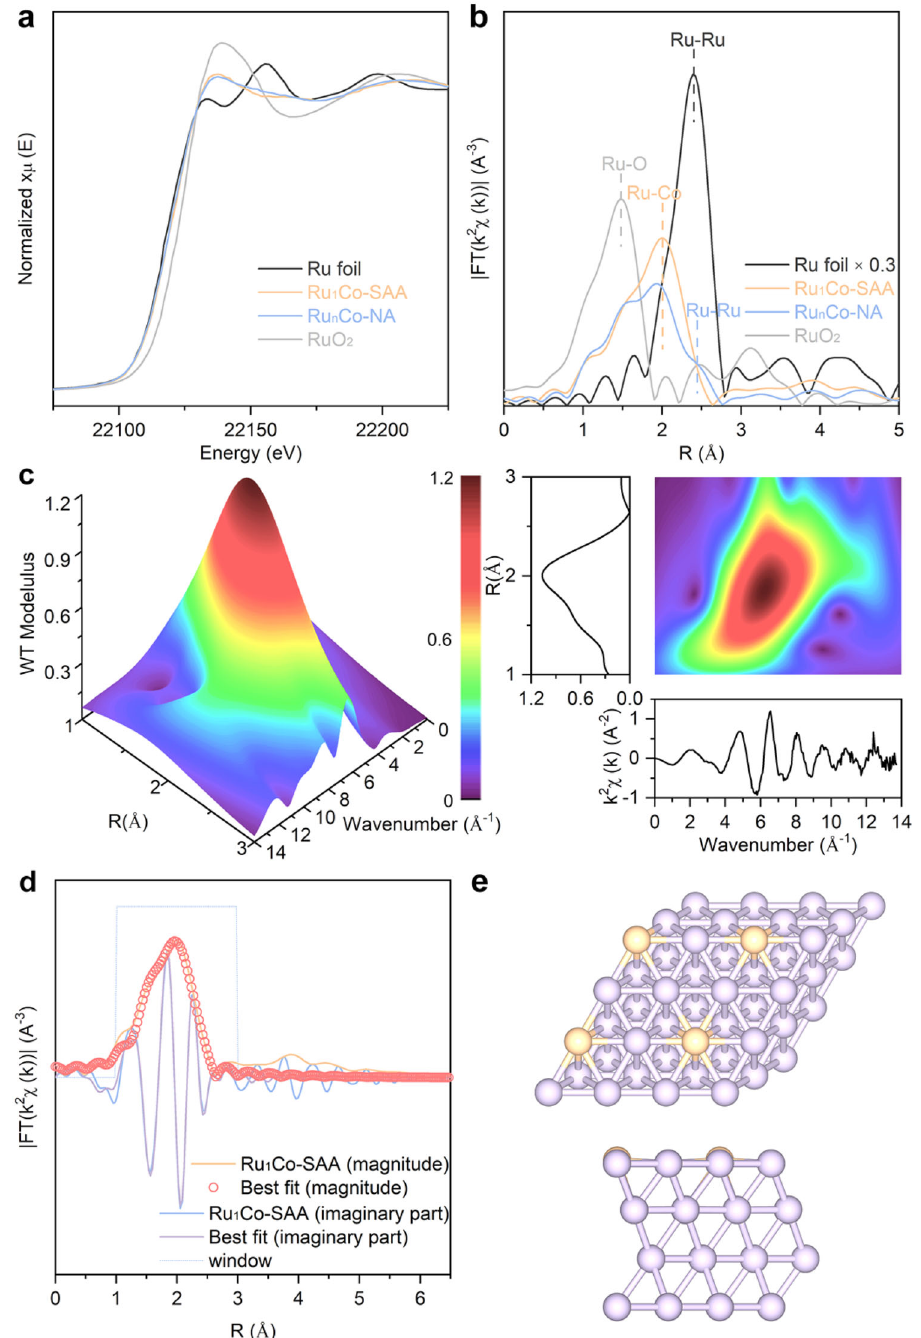
Fig. 3| Structuralcharacterization oftheRu 1 Co-SAAcatalyst.a RuK-edgeXANESforRu 1 Co-SAAandRu n Co-NA. b EXAFSspectrain R -spaceforRu 1 Co-SAAand Ru n Co- NA. c WT analysis of Ru 1 Co-SAA. d EXAFS fi tting curves in R -space for Ru 1 Co-SAA. e The optimized structure of Ru 1 Co-SAA. Color code: Ru (orange), Co